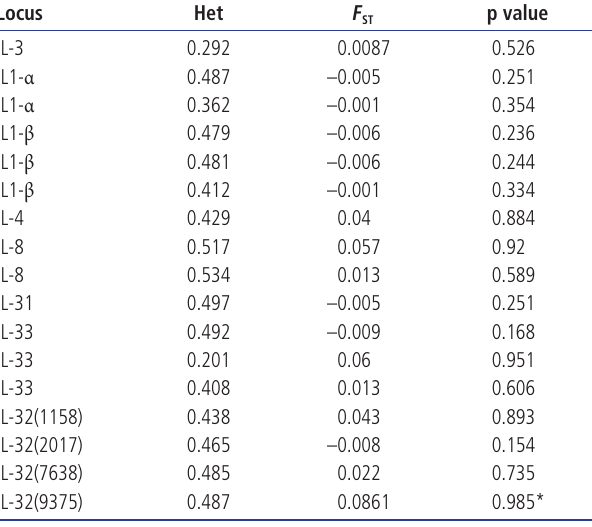
Table 1. Locus, heterozygosity (He) and fixation index (F SNPs